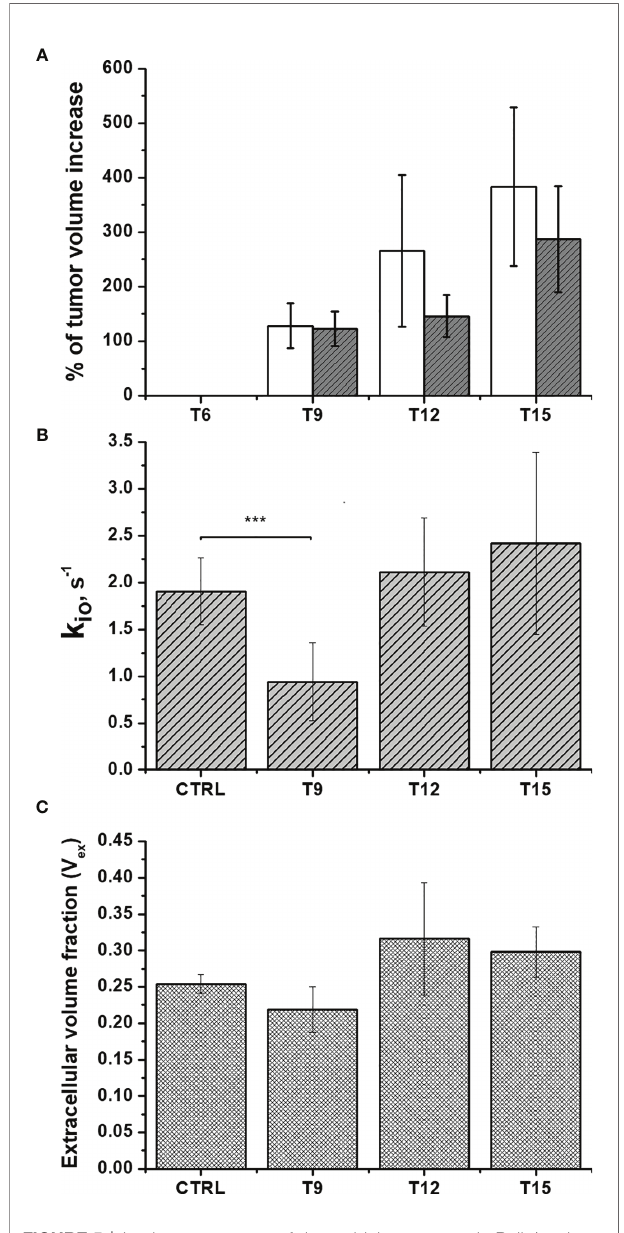
FIGURE 5 | In-vivo assessment of doxorubicin treatment in Balb/c mice that bear 4T1 tumors: (A) The percentage of volume increase in the tumor region as determined by T 2 -weighted images acquired at 1 T using the ITK-SNAP software. Open and fi lled bars correspond to untreated and treated mice, respectively; (B) The cellular water ef fl ux rate constant, k io (s -1 ) and (C) The extra-cellular volume fractions (V ex ) were calculated via the analysis of the multi-relaxation rate measurements in the range 0.01-1MHz using the 2SX model for treated animals (n=8) compared to control animals (n=7). Error bars represent the SD of the experimental data. (***p ≤ 0.001).